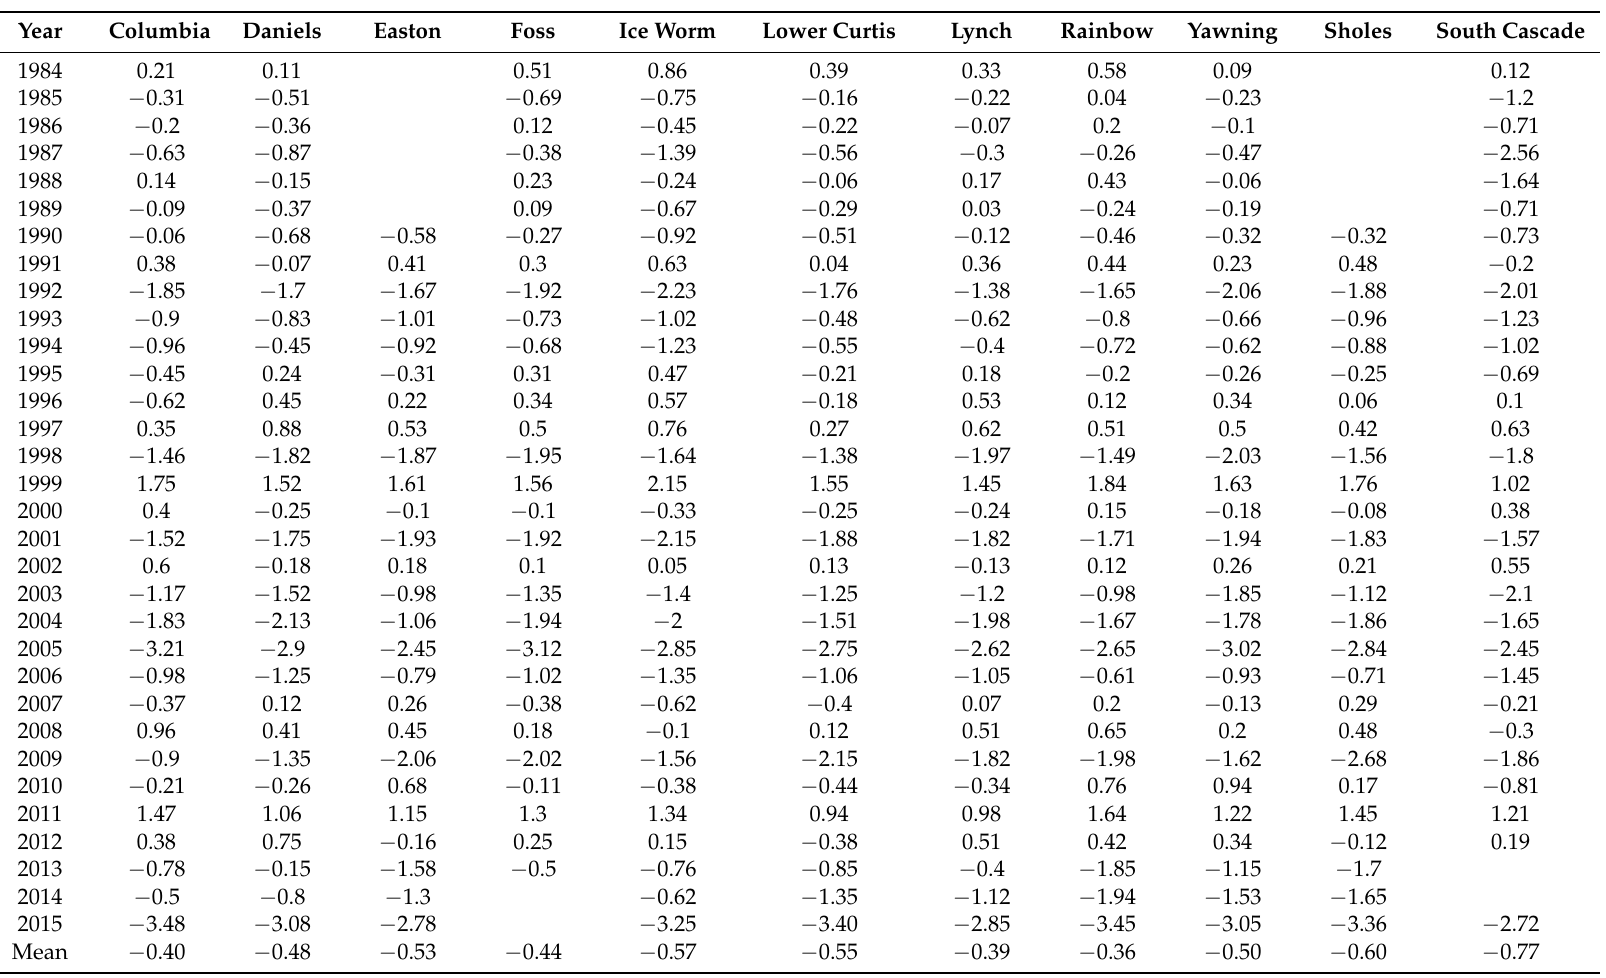
Table 2. Annual mass balance of the North Cascades glaciers from 1984–2015. The South Cascade Glacier was observed by the USGS, all of the others were observed by the North Cascade Glacier Climate Project